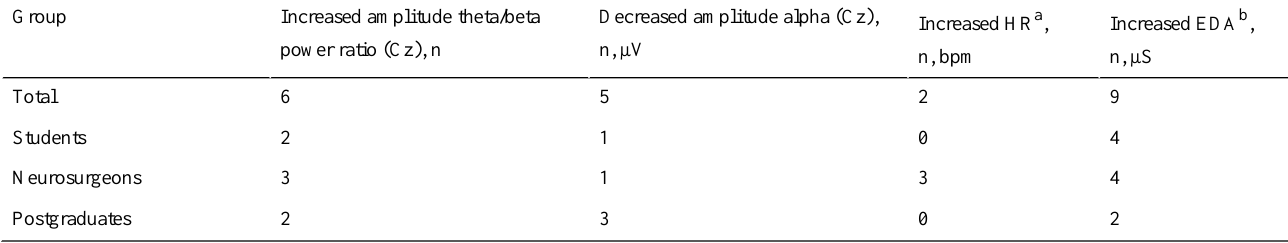
Table 5. Biosignal average value shifts for the virtual reality/mixed reality educational